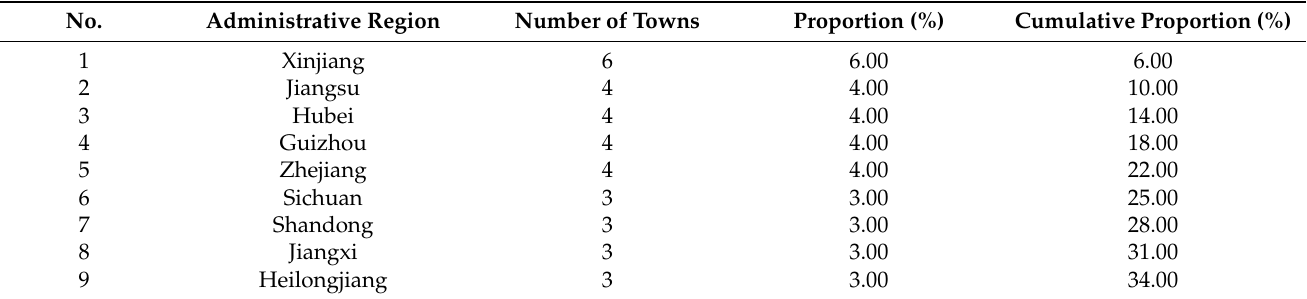
Table 1. Statistics on the regional distribution of the